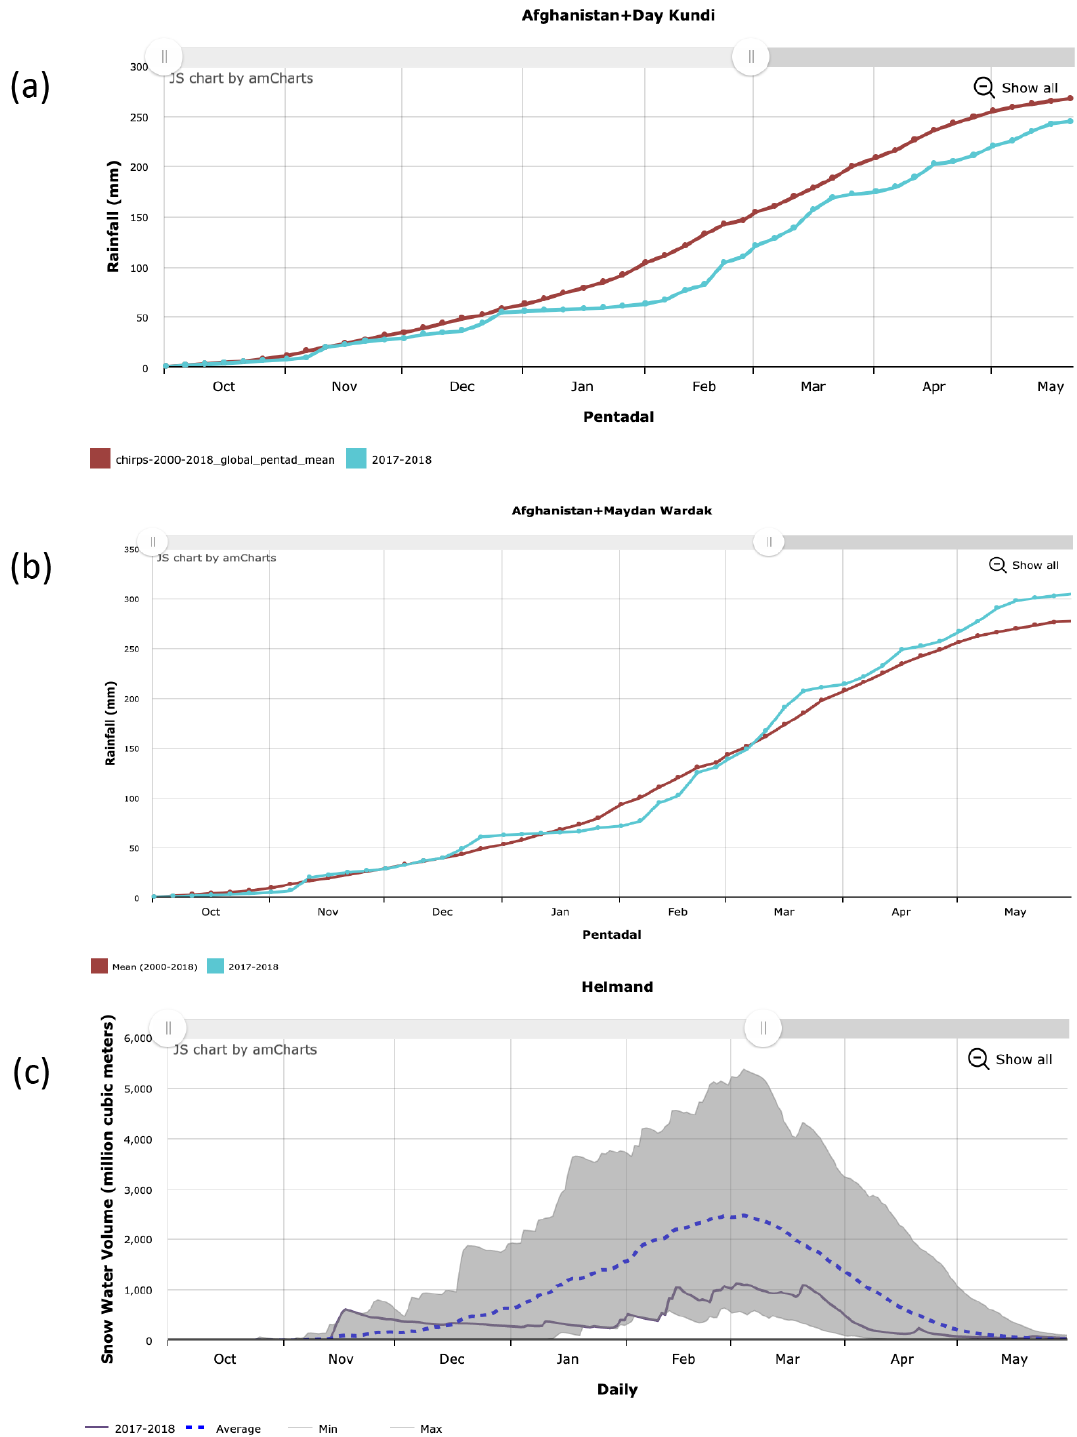
Figure 10. (a) CHIRPS cumulative rainfall for 2017–2018 versus average conditions for Daykundi Province. (b) CHIRPS cumulative rainfall for 2017–2018 versus average conditions for Maydan Wardak Province and (c) Helmand Basin SWE from the FLDAS Central Asia data stream. The gray shading indicates the range of the minimum and maximum values, the dashed blue line is the average, and the black line is 2017–2018. Figures from USGS EWX (https://earlywarning.usgs.gov/fews/ewx/, last access: 24 June 2022).